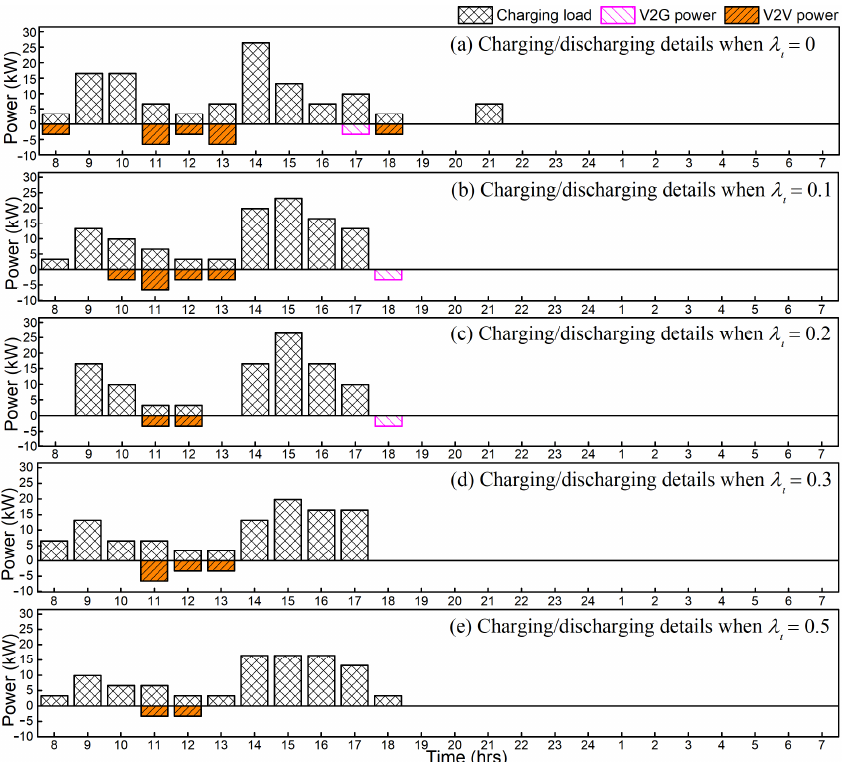
Figure 15. Details of the aggregated EV charging/discharging profiles for the charging station with different λ i : ( a – e ): λ i = 0, 0.1, 0.2, 0.3 and 0.5 respectively; with the increase of λ i , EVs choose to perform less discharging.